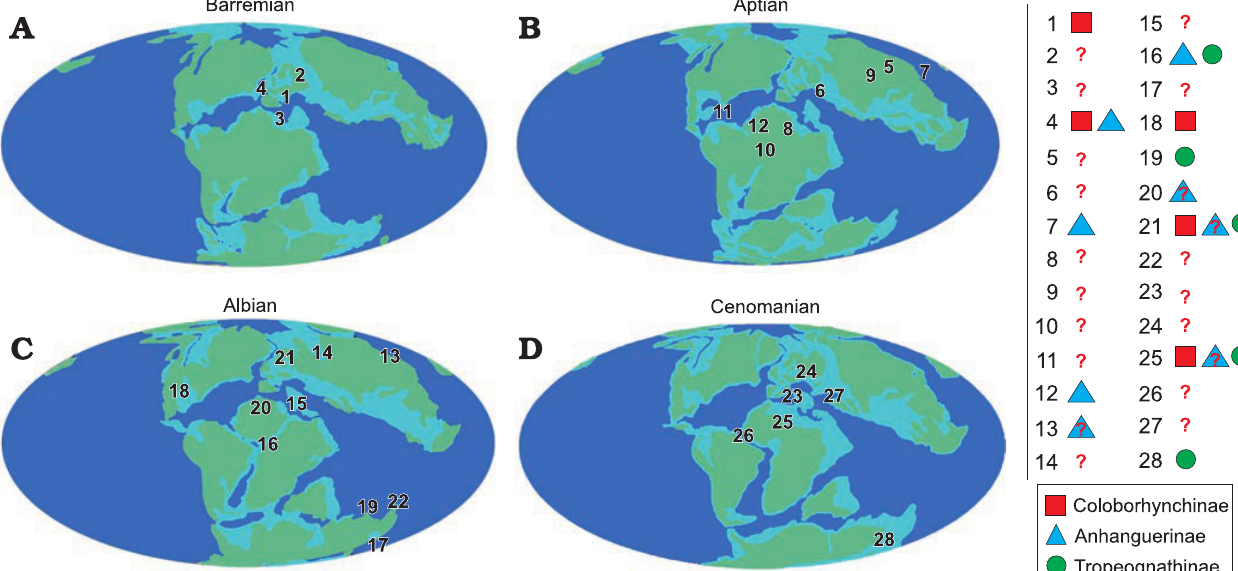
Fig. 13. Paleogeographic maps showing distribution of Anhangueridae. A . Barremian: 1, St. Leonards­on­Sea, East Sussex, Hastings Group (late Berriasian/Valanginian), England; 2, Bol’shoi Kemchug, lower Ilek Formation (?Hauterivian–Barremian) Krasnoyarsk Krai, Russia; 3, Las Hoyas, La Huérgina Formation (Barremian), Cuenca, Spain; 4, Isle of Wight, Wessex Formation (Barremian), England. B . Aptian: 5, Mogoito, Murtoi Formation (Aptian), Buryatia, Russia; 6, Sekmenevka Formation (Aptian), Belgorod Oblast, Russia; 7, Jiufotang Formation (Aptian), Liaoning, China; 8, Elrhaz Formation (Aptian), Niger; 9, Krasnyi Yar, Khilok Formation (Aptian), Buryatia, Russia; 10, Pedra Furada, Recôncavo Basin, Marizal Formation? (Aptian), Bahia, Brazil; 11, Sierra de Perijá, Apón Formation (Aptian), Zulia, Venezuela; 12, Crato Formation (late Aptian), Ceará, Brazil. C . Albian: 13, Khuren­Dukh, Dzun­Bayin Formation (late Aptian–Albian), Mongolia; 14, Sheskatovo, upper Ilek Formation (late Aptian–Albian), Kemerovo Oblast, Russia; 15, Chenini Formation (early Albian), Tunisia; 16, Romualdo Formation (Albian), Ceará, Brazil; 17, Lightning Ridge, Griman Creek Formation (Albian), New South Wales, Australia; 18, Tarrant County, Paw Paw Formation (Albian), Texas, USA; 19, Boulia, Toolebuc Formation (Albian), Queensland, Australia; 20, Cortes de Arenoso, Utrillas Formation (Albian), Valencia, Spain; 21, Cambridge Greensand (Cenomanian, but fossils Albian in age), England; 22, Hughenden, Mackunda Formation (late Albian), Queensland, Australia. D . Cenomanian: 23, Strelitsa Graysand with phosphorite (late Albian–Cenomanian), Voronezh Region, Russia; 24, Pavlovsk (Cenomanian), Voronezh Region, Russia; 25, Kem Kem beds, lower Ifezouane and